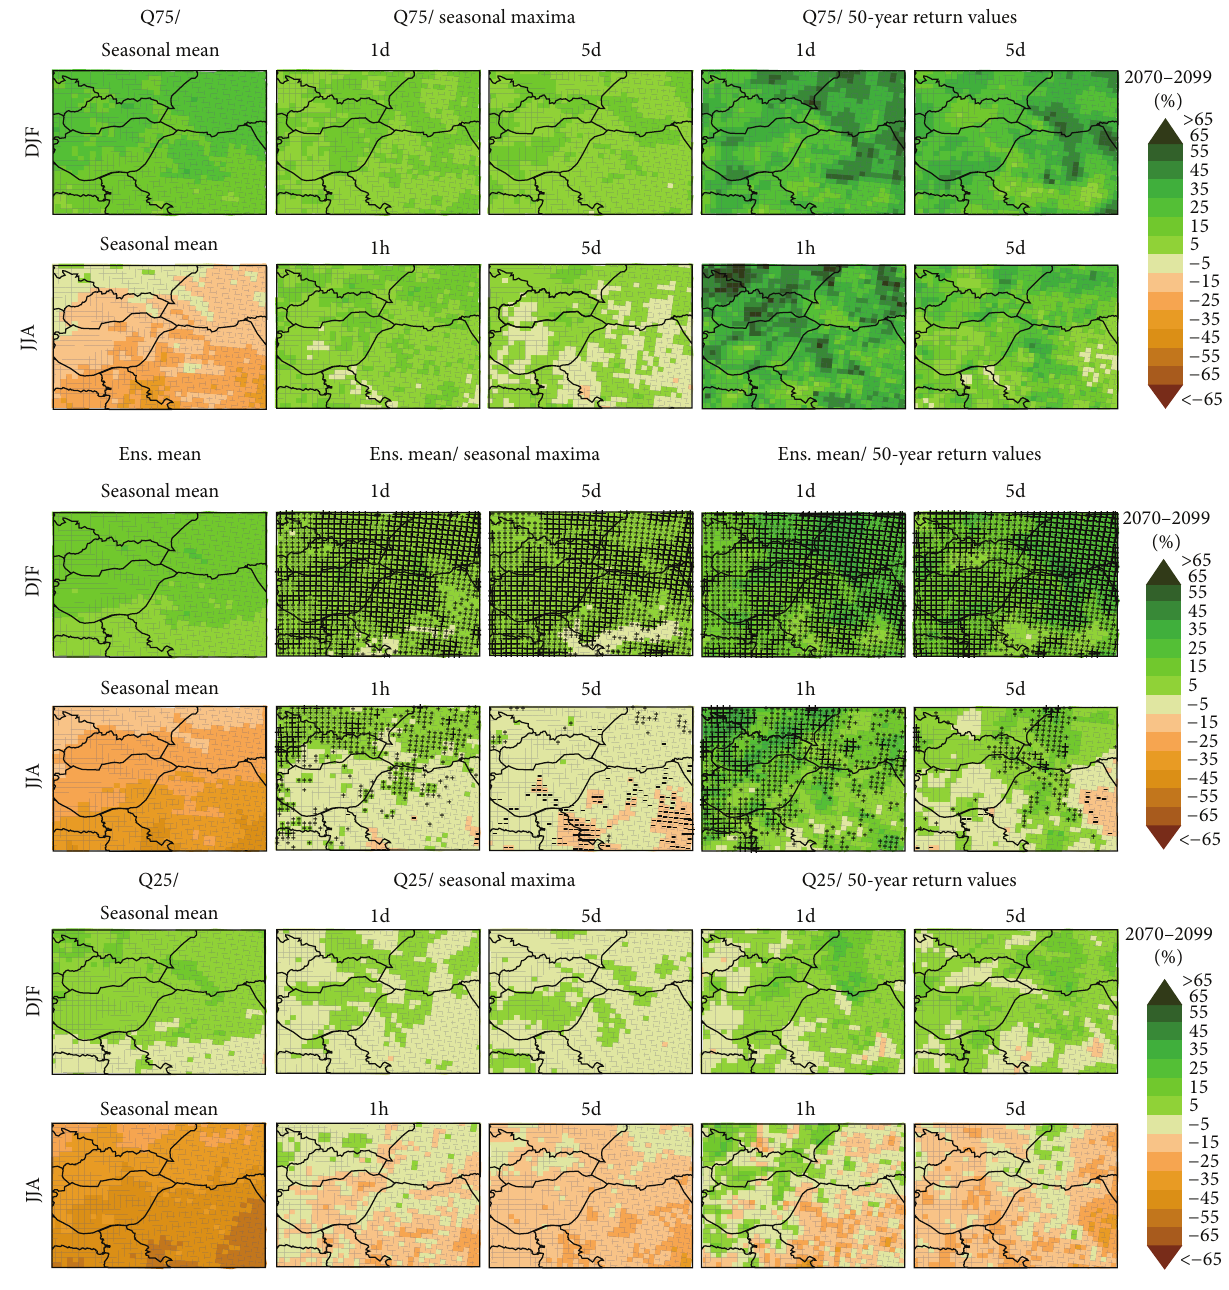
Figure 3: Ensemble mean and ensemble quantiles (Q25 and Q75) of the projected relative changes (in %) for the late 21st century (2070– 2099) in comparison with the control period (1961–1990) of mean seasonal precipitation, mean seasonal maxima of 1-hour/1-day and 5-day precipitation, and 50-year return values of 1-hour/1-day and 5-day precipitation assessed by the pooling (ROI) approach. Large (small) “+/ − ” signs indicate grid boxes where at least 10 (8) of the 12 RCMs agree on the sign of change for the given precipitation characteristic. For further details and explanation, see